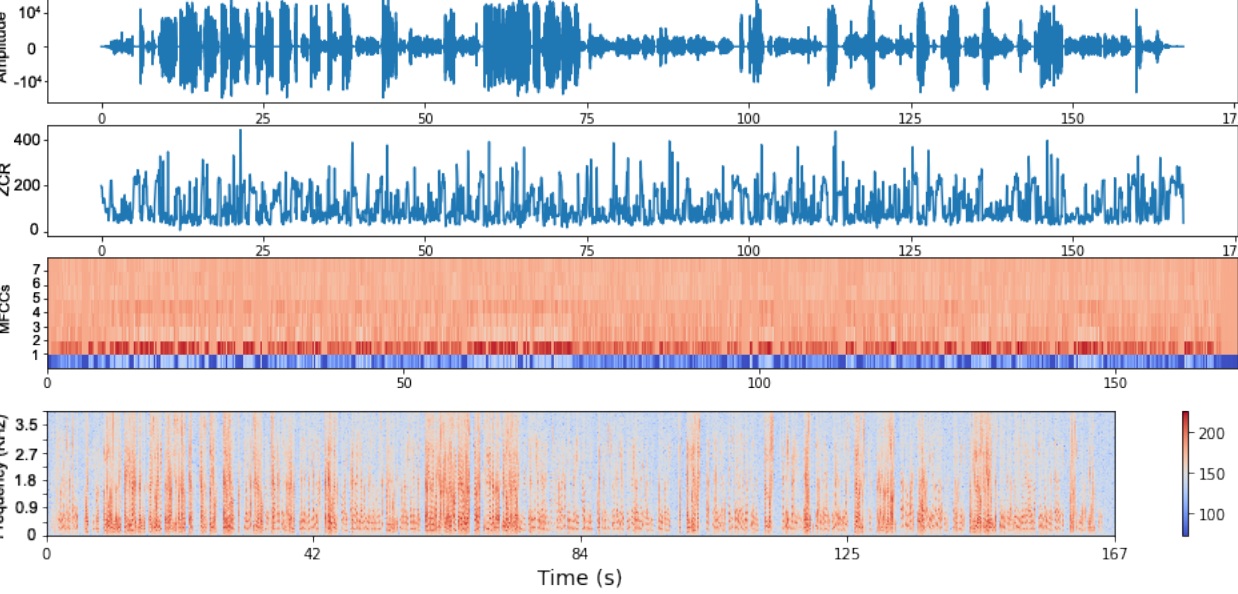
Figure 6. A representation of a consultation’s acoustic signal. The first plot is the signal in time domain, the second is the ZCR, the third shows the MFCCs (showing the first 8 coefficients), and the fourth is the spectrogram